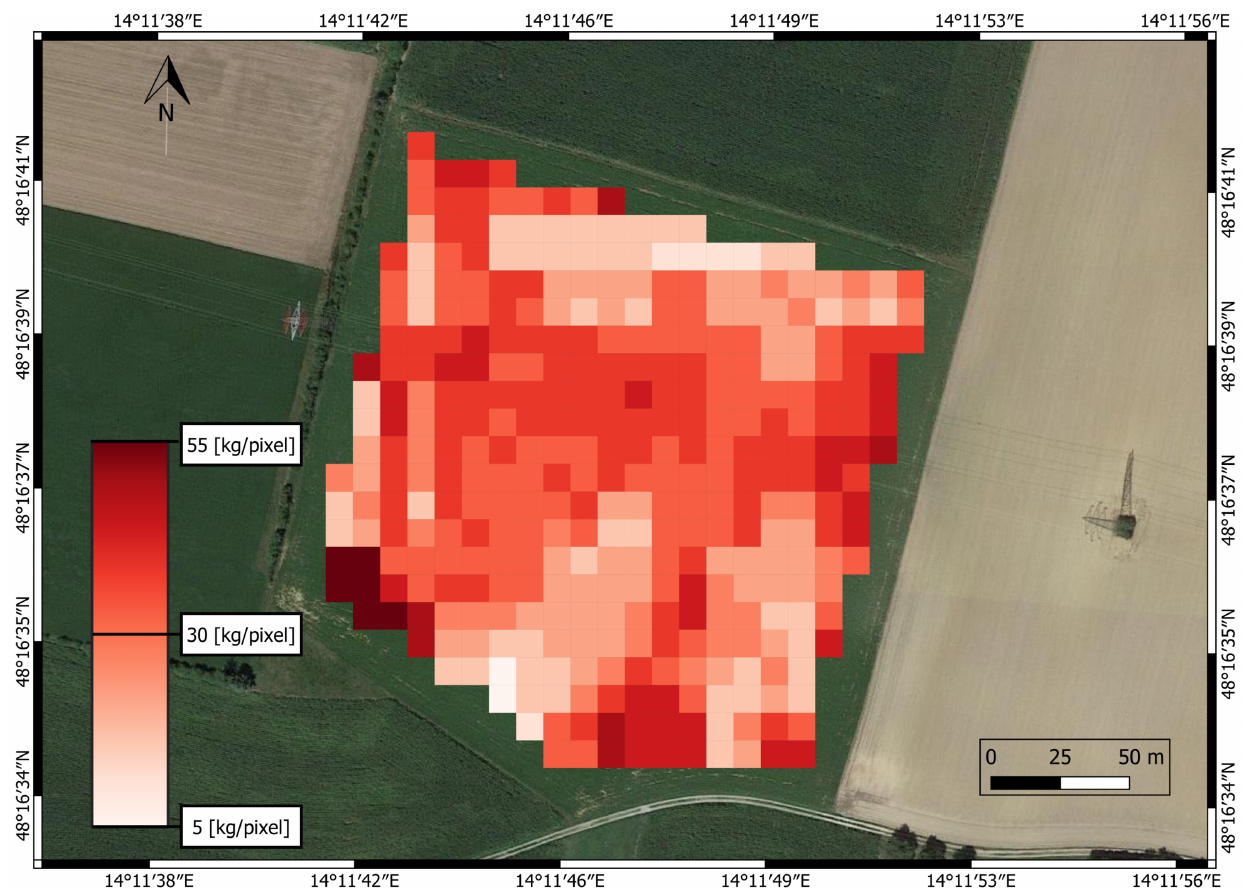
Figure 12. Yield map—the output of the pre-trained model in the form of a